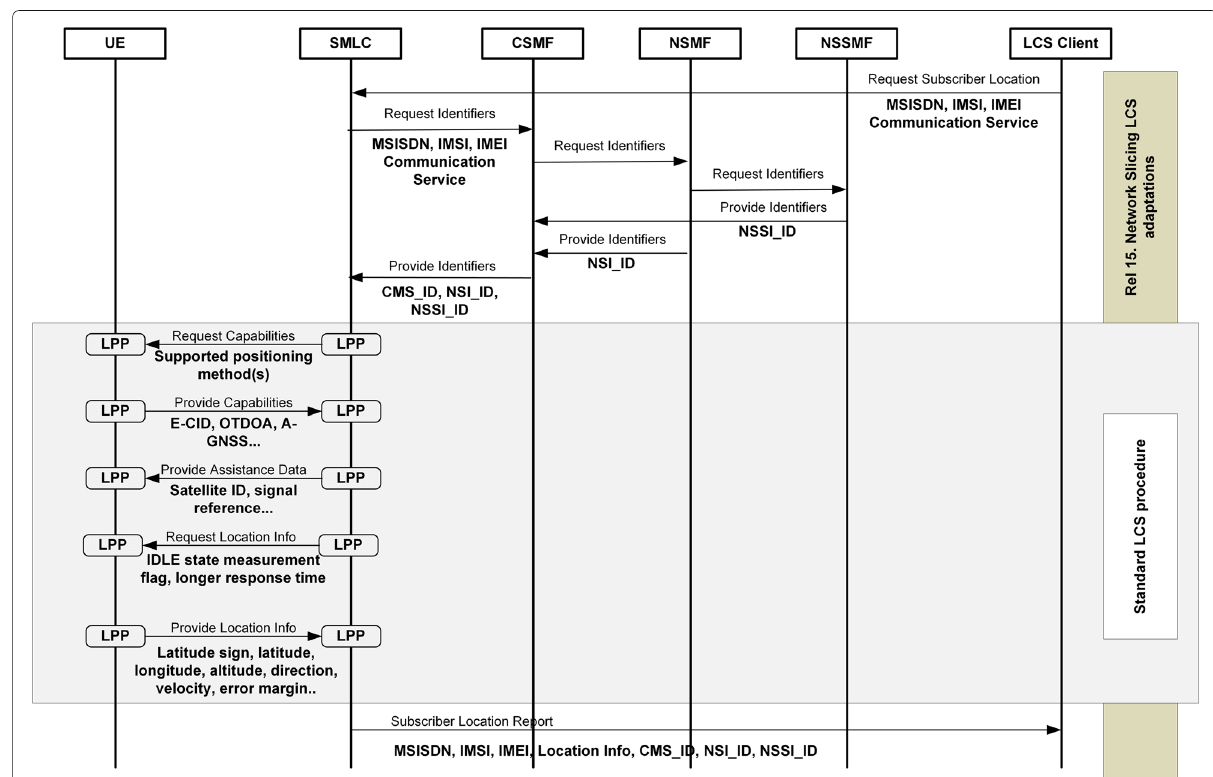
Fig. 13 LALS adaptation for the Rel. 15 network slicing architecture. Few extra steps are added in the LCS procedure so the SMLC can include the CMS_ID, NSI_ID, and NSSI_ID in the subscriber location reports sent back to the